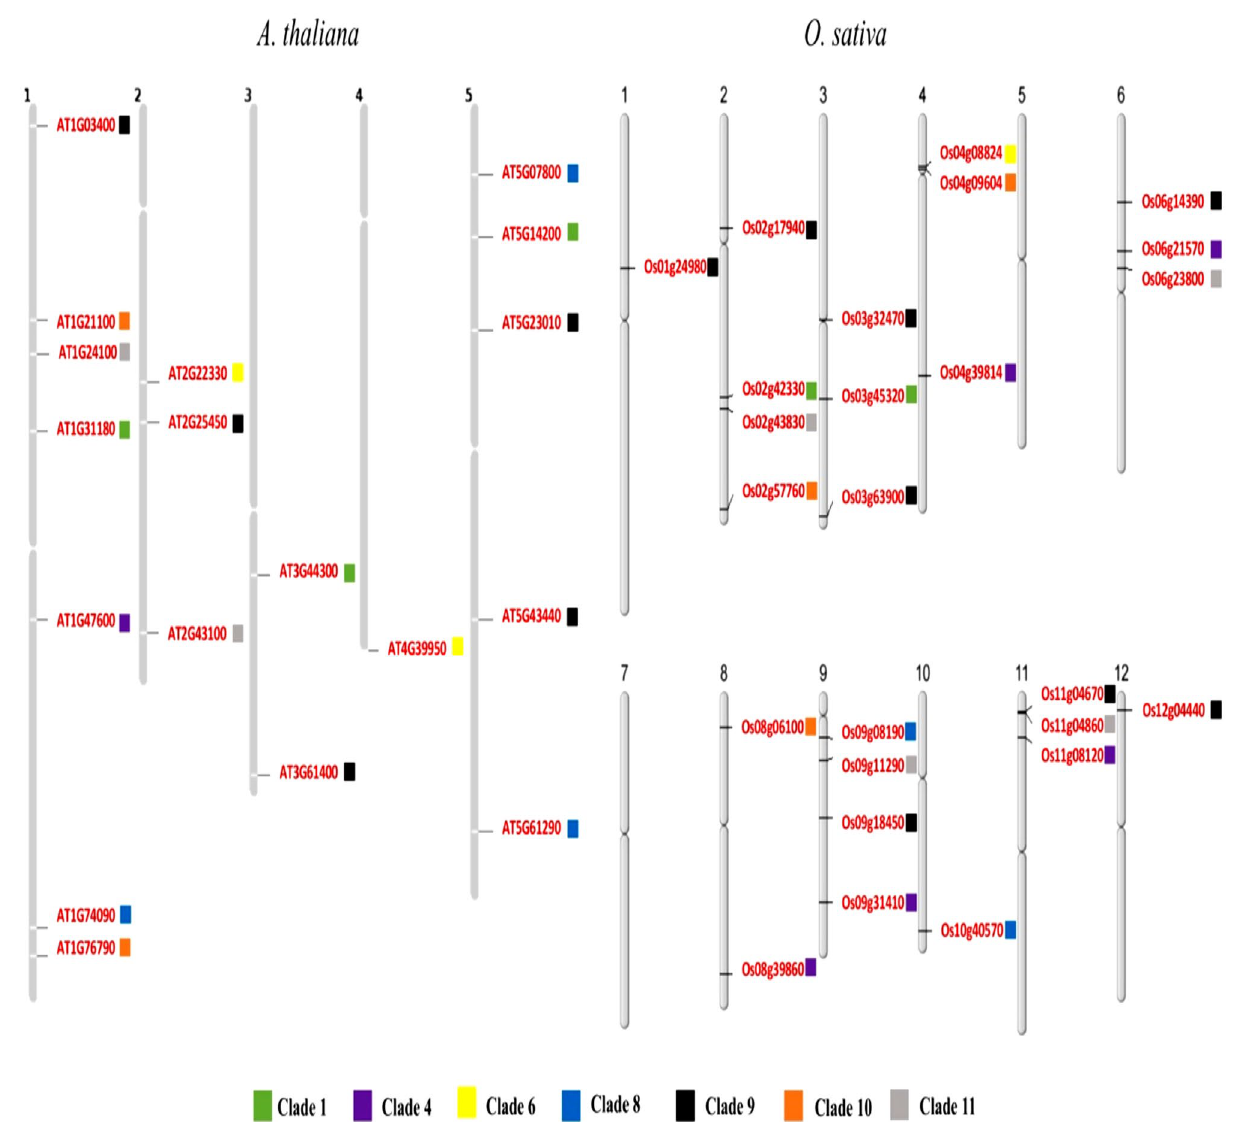
Figure 5. Sulfur-containing compound (SCC) encoding biosynthetic gene distribution in A. thaliana and O. sativa chromosomes. Grey bars represent the physical maps. The chromosomes are numbered accordingly: A. thaliana ;1–5 and O. sativa ;1–12. Short lines on grey bars represent the locations of SCCs biosynthetic genes (labelled in red) on each physical map. The different colour boxes expressed adjacent to the gene ID represent the